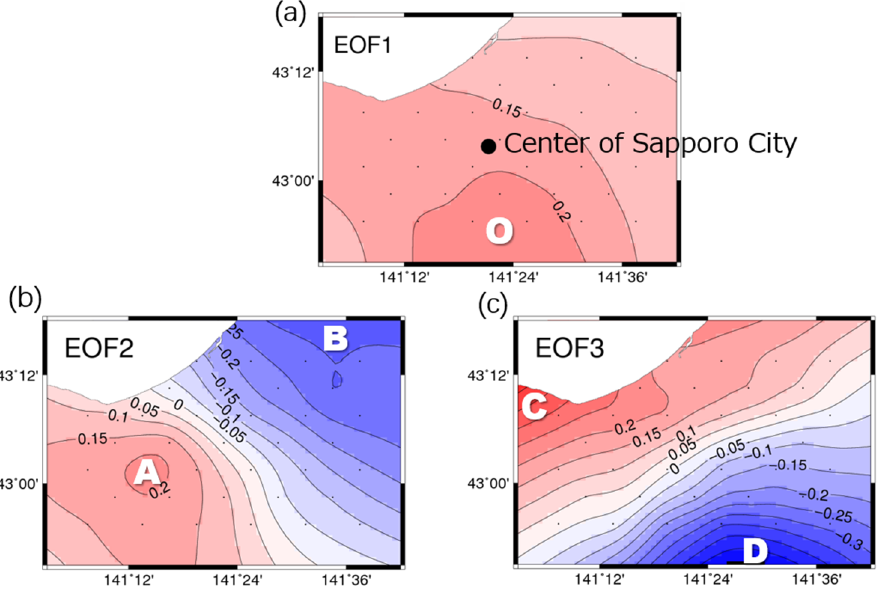
Figure 5. Horizontal distribution of eigenvectors of ( a ) EOF1, ( b ) EOF2, and ( c ) EOF3. The contour interval is 0.05, and red/blue indicates positive/negative. The dots in each map indicate the 36 grids subjected to EOF analysis. The mark “O” indicates the maximum of the eigenvector of EOF1, the marks “A” (“B”) indicate the maxima of positive (negative) eigenvector of EOF2, and “C” (“D”) indicate the same for EOF3.